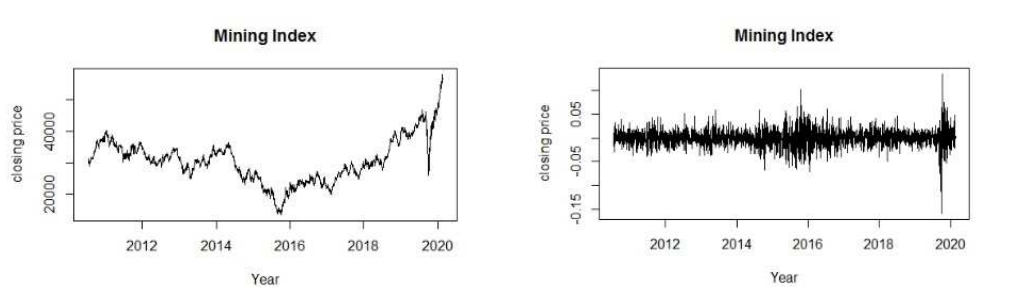
Figure 3. Time series plot of FTSE/JSE Mining Index prices (left) and one-day returns (right)